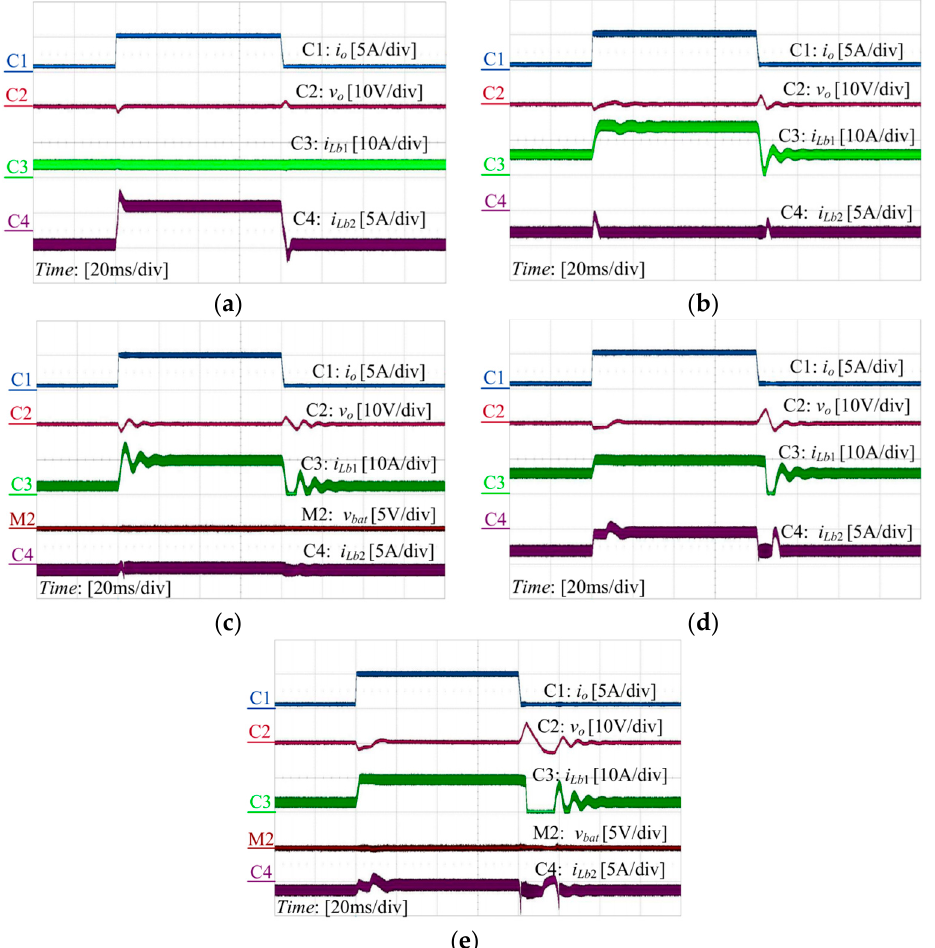
Figure 10. Experiment waveforms of load stepping up and load stepping down: ( a ) M 1 with I pvref = 0.35 A ( P m = 105 W), V ocbat = 39 V; ( b ) M 2 with I pvref = 2 A ( P m = 600 W), V ocbat = 39 V; ( c ) M 3 with I pvref = 2 A ( P m = 600 W), V ocbat ≈ 40 V; ( d ) I pvref = 0.93 A ( P m = 280 W), V ocbat = 39 V; ( e ) I pvref = 0.93 A ( P m = 280 W), V ocbat ≈ 40